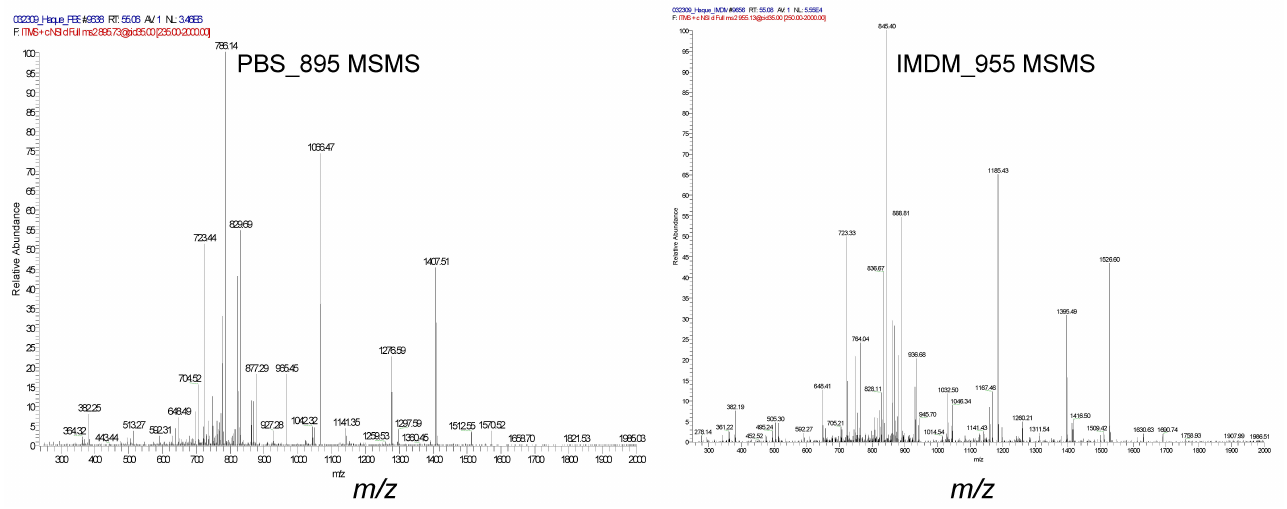
Figure 7. Mass spectroscopic analysis of the PSMA459 (NYTLRVDCTPLMYSL) peptide. The PSMA (459–473) peptide was dissolved in PBS and culture medium (IMDM) which contains biological levels of cystine (0.29 mM). The PSMA459 peptide fragmentation in PBS was consistent with the calculated molecular mass of 1789.7 (upper panel). Fragmentation of the PSMA 459 peptide after incubation in IMDM media indicated a mass of 1908.7, consistent with cysteinylation. MSMS analyses in PBS and IMDM are shown in the lower panels. These data suggest that the PSMA 459 peptide becomes cysteinylated in media containing a physiological concentration of